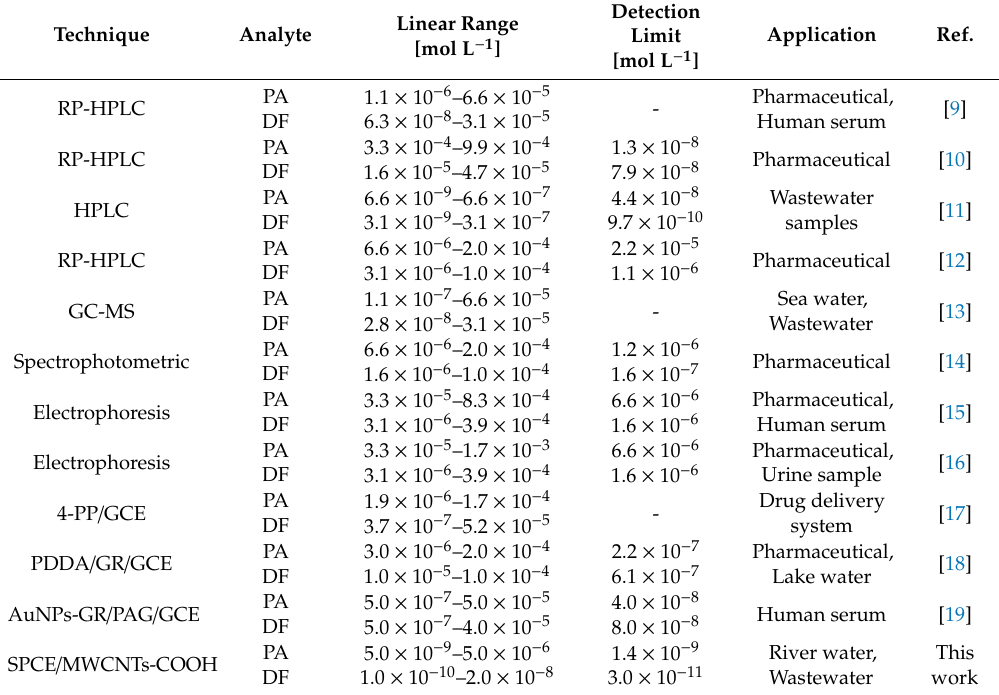
Table 2. Comparison of techniques for simultaneous analysis of PA and